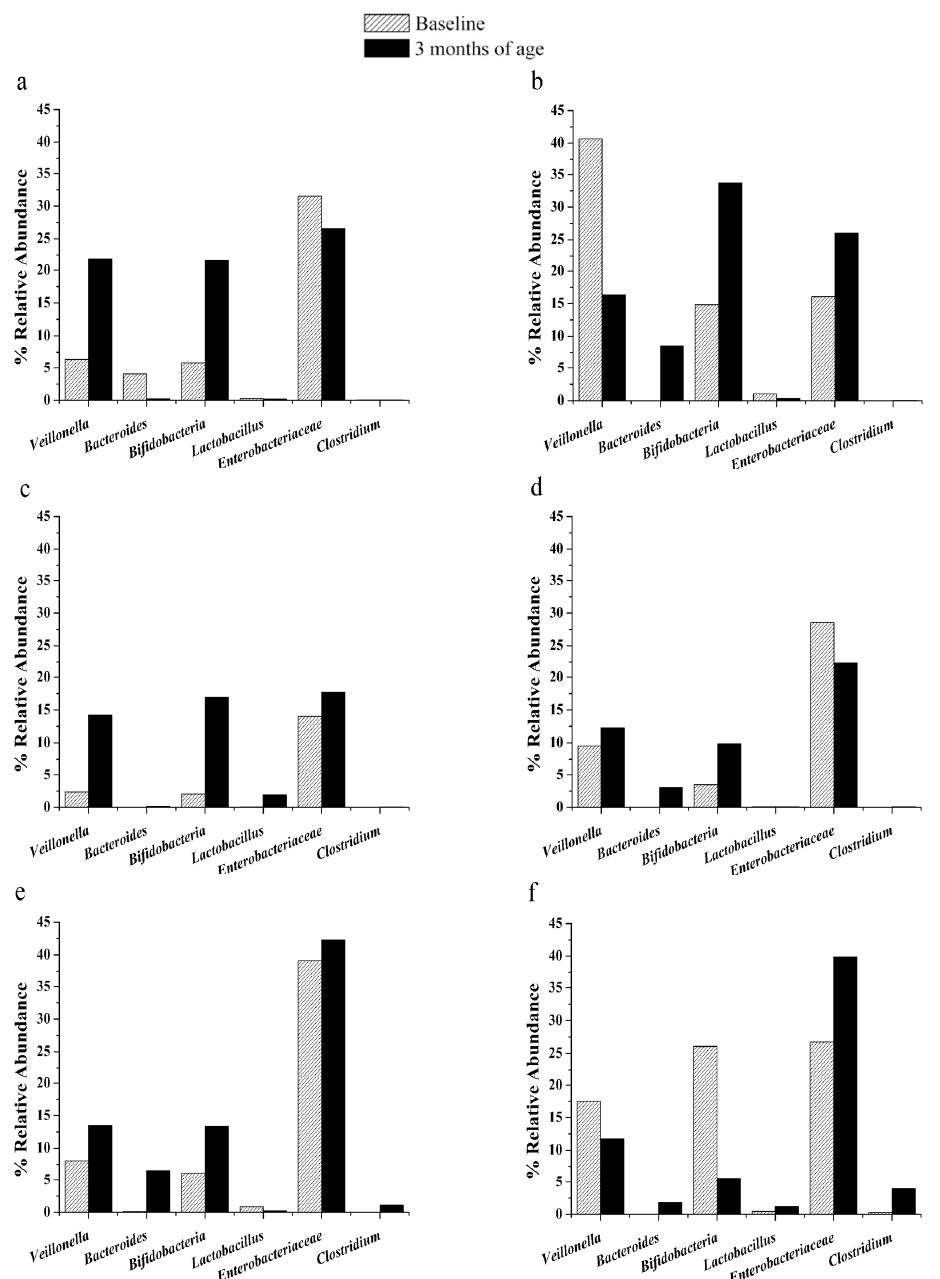
Figure 1. Changes in the relative abundance of gut bacteria, according to the kind of feeding after three months of treatment. Data from total counts were taken as 100% to normalize all the other counts. Reference group of breast milk fed ( a ), and Groups 1, 2, 3, 4, and 5, ( b – f ), respectively.